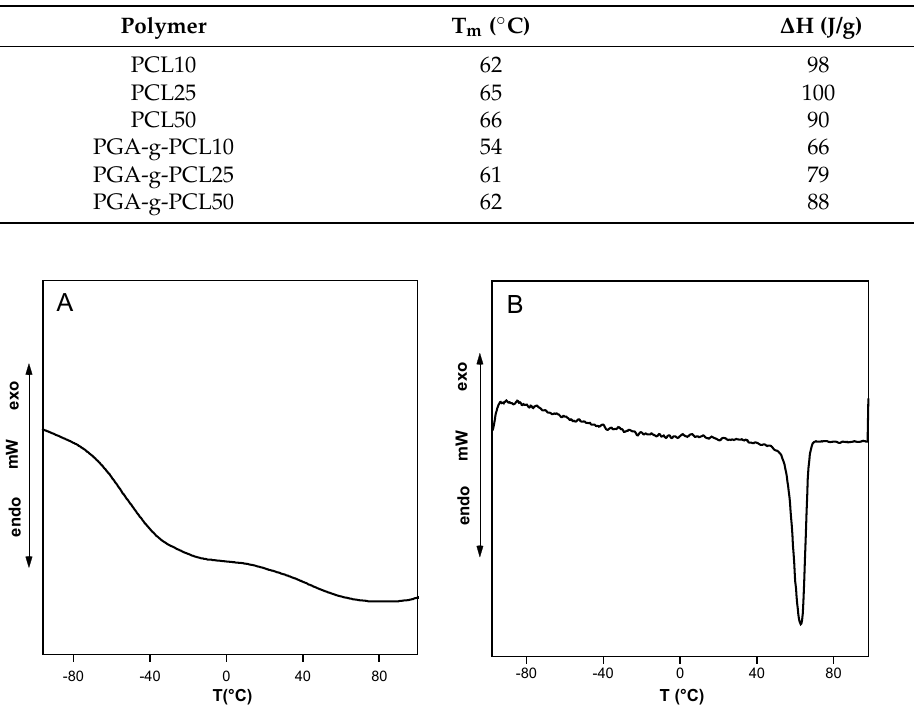
Figure 2. DSC thermograms of the homopolymers PGA ( A ) and PCL10 ( B ).